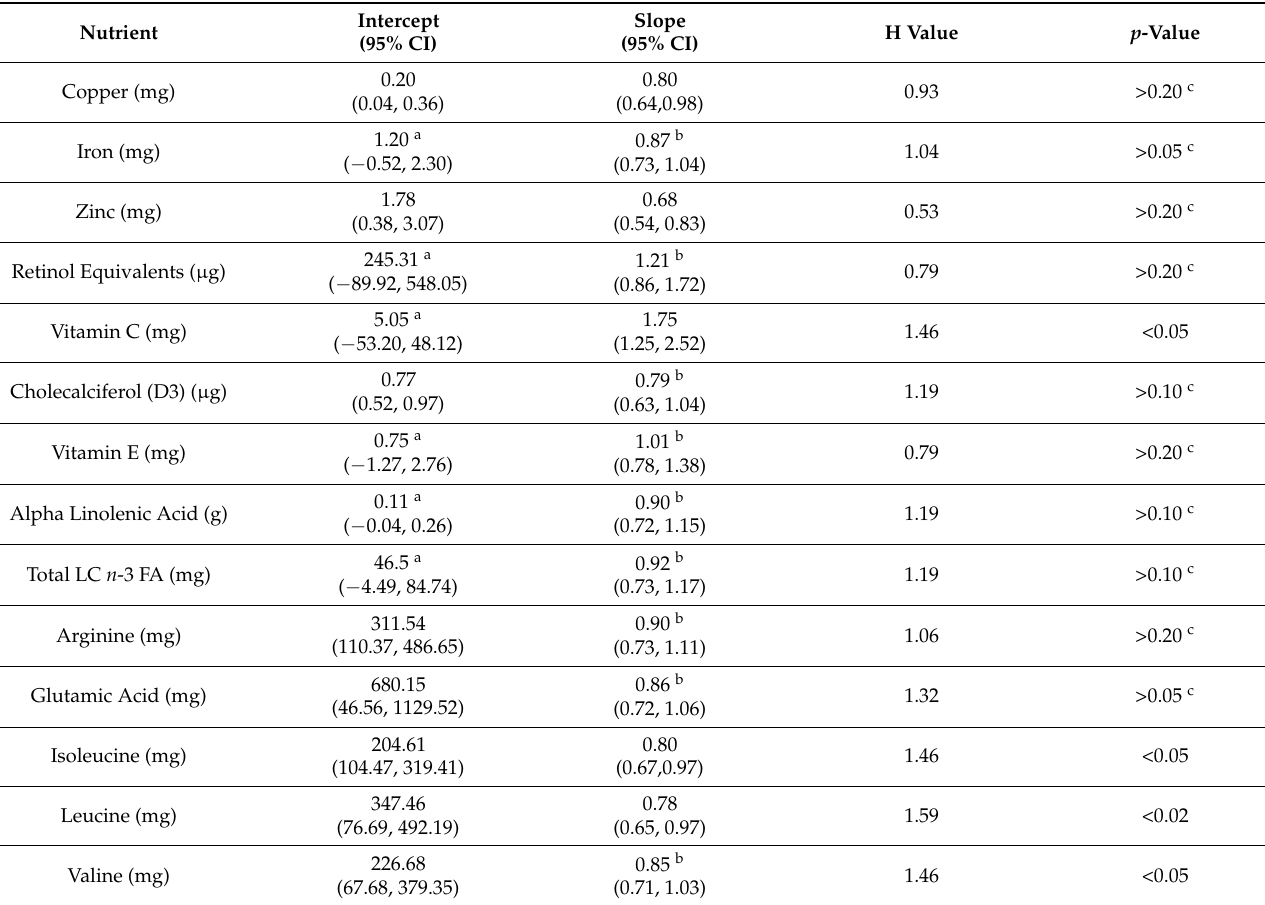
Table 3. Summary of results from Passing–Bablok regression test presenting intercept and slope with respective 95% confidence intervals (95% CI) and cumulative sum linearity (cusum linearity) test with respective p -values.